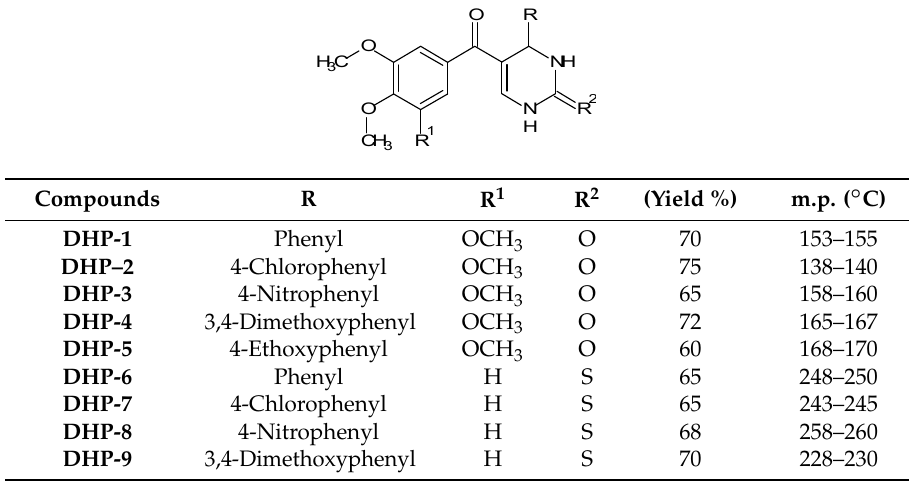
Table 1. Physical data of the synthesized dihydropyrimidinone/thione compounds ( DHP 1 – 9 ).